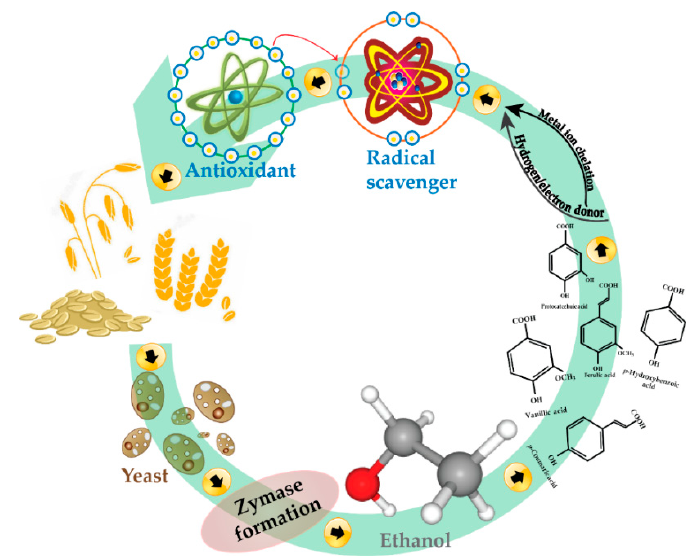
Figure 4. A schematic showing how the effect of yeast fermentation on the antioxidant activity of cereals takes place.